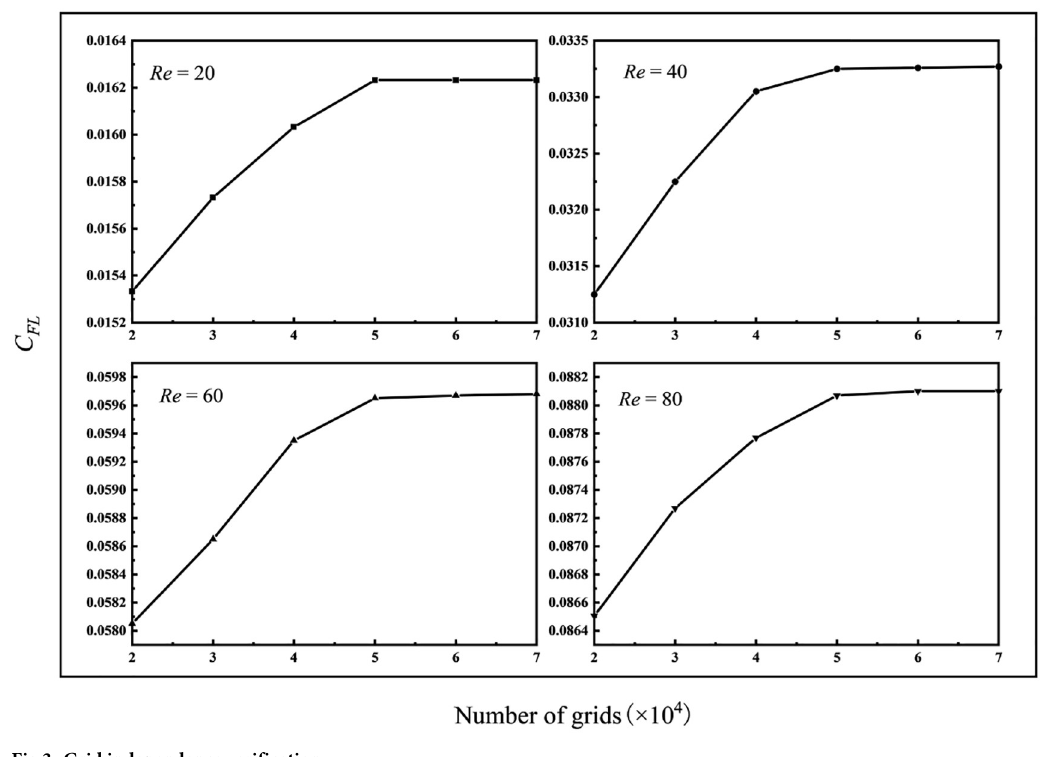
Fig 3. Grid independence